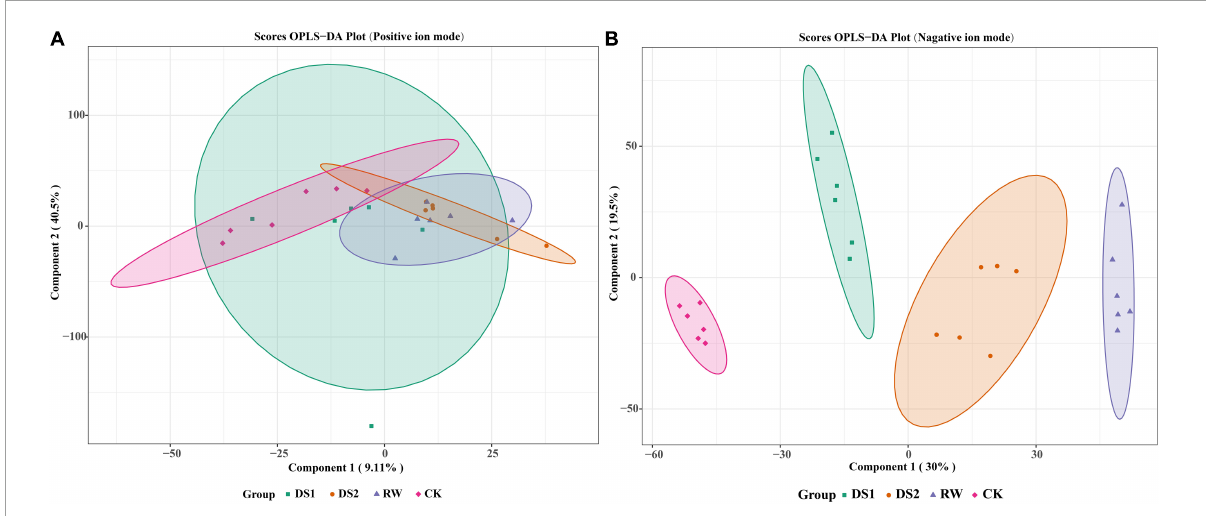
FIGURE3 OPLS-DA score plots for metabolic profiling analysis in positive (A) and negative (B) ion modes. The score of variation explained by each principal component is indicated on the axes. Each point corresponds to a plant sample, and different colors indicate the different treatments.